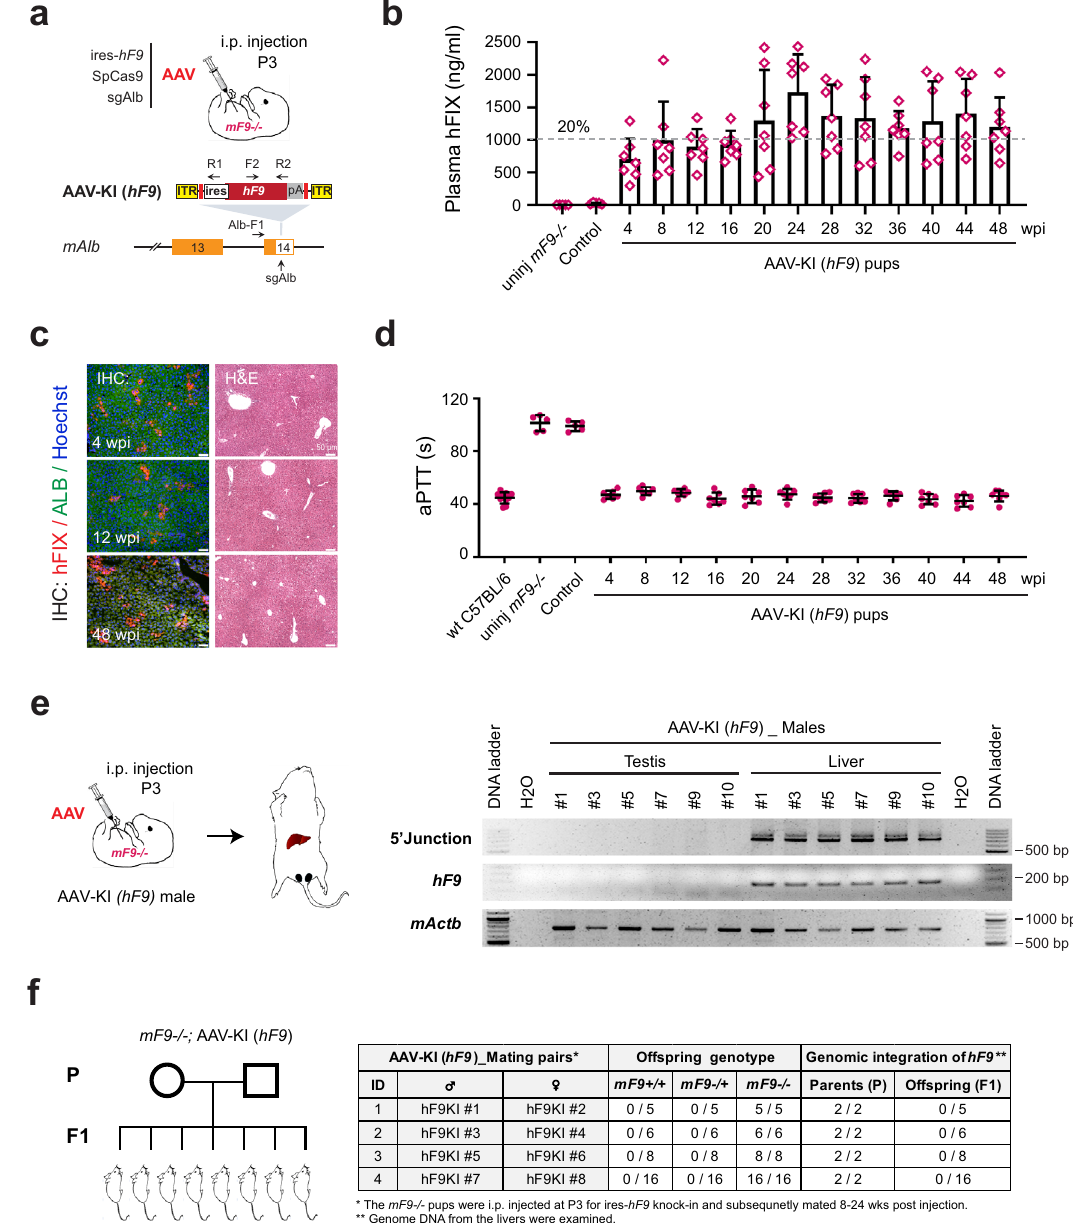
Fig. 3 | NHEJ knock-in of hF9 in neonatal mice corrected hemophilia B without modifying germline genome. a Schematics for i.p. injection of AAVs carrying SpCas9, sgAlb/sgA and ires- hF9 into neonatal mF9 − / − pups at postnatal day 3 (P3) (upper), AAV vector carrying ires- hF9 (middle) and the sgAlb target site at mAlb 3 ’ UTR (lower). b hFIX protein levels in pup plasma after i.p. injection of AAVs carrying SpCas9 (1×10 11 vg/mouse), sgAlb/sgA (1×10 11 vg/mouse), and ires- hF9 donor (2×10 11 vg/mouse) ( n =7). The Control group was injected with ires- hF9 donoronly( n =5),anduninjected mF9 − / − micewereexaminedasreference( n =5). ELISAwasperformed using ananti-hFIX antibody,and data for AAV-KI ( hF9 )group werecollectedevery2 – 4weeksuntil48wpi.Dashedlinesrepresent20%ofnormal FIXlevels.Dataaremean±SD. c IHCandH&EstainingonliversofAAV-KI( hF9 )pup sacri fi cedat4,12,and48wpi.Hepatocyteswerestainedusingantibodiesspeci fi cto